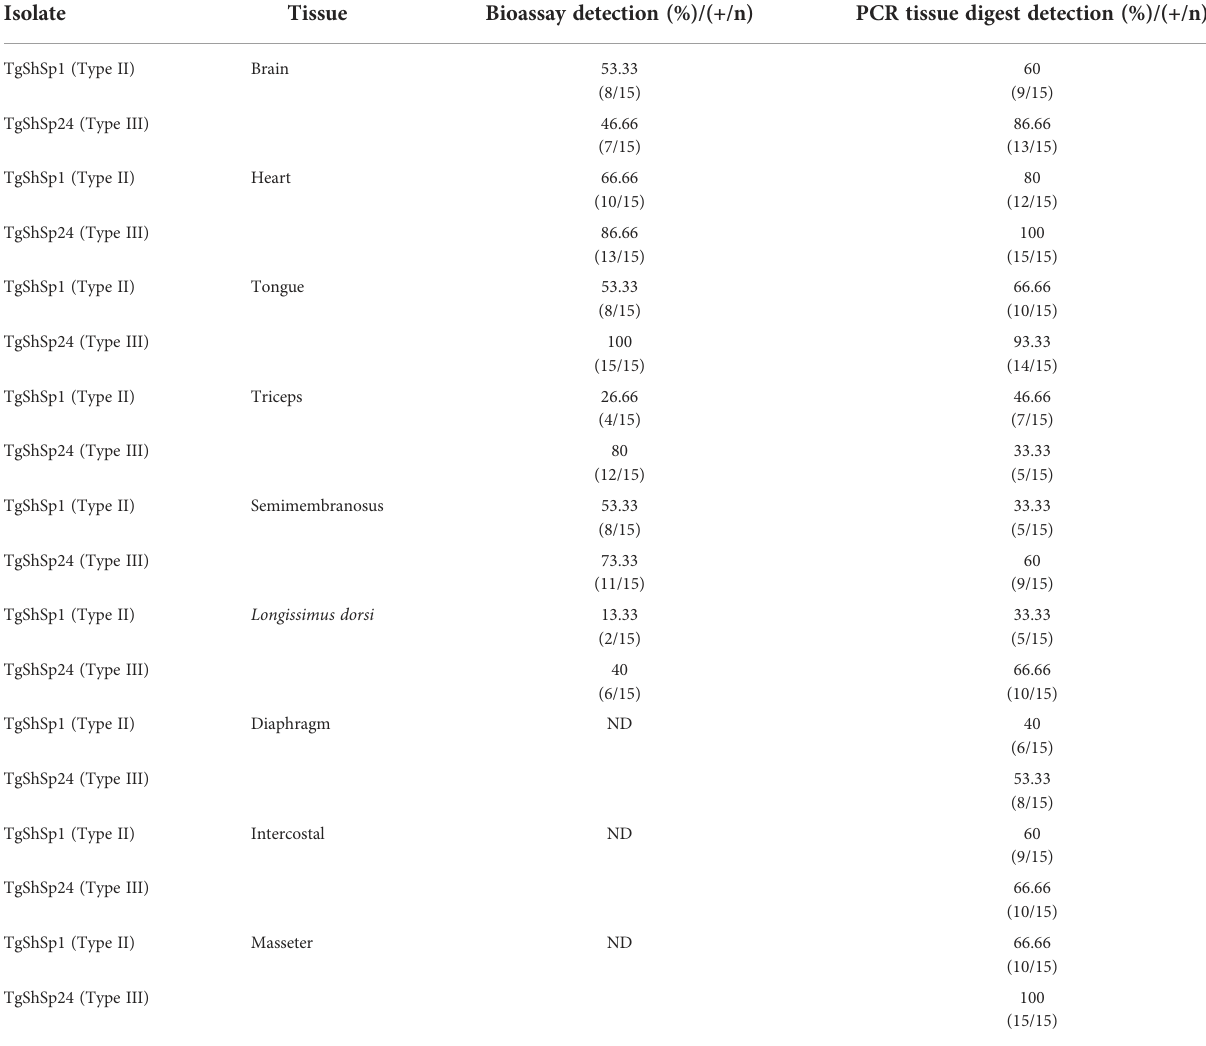
TABLE 2 Frequency of Toxoplasma gondii detection in tissues of the infected piglets by mouse bioassay and 529pb RE qPCR. Isolate Tissue Bioassay detection (%)/(+/n) PCR tissue digest detection